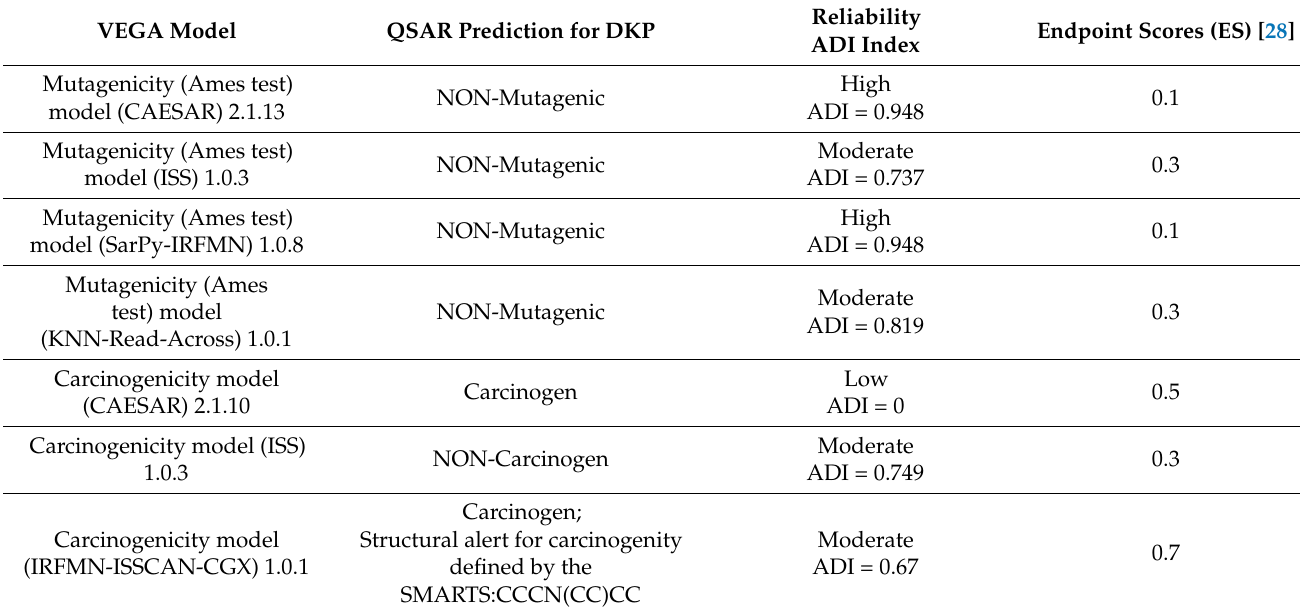
Table 3. QSAR predictions for DKP carcinogenicity, genotoxicity and